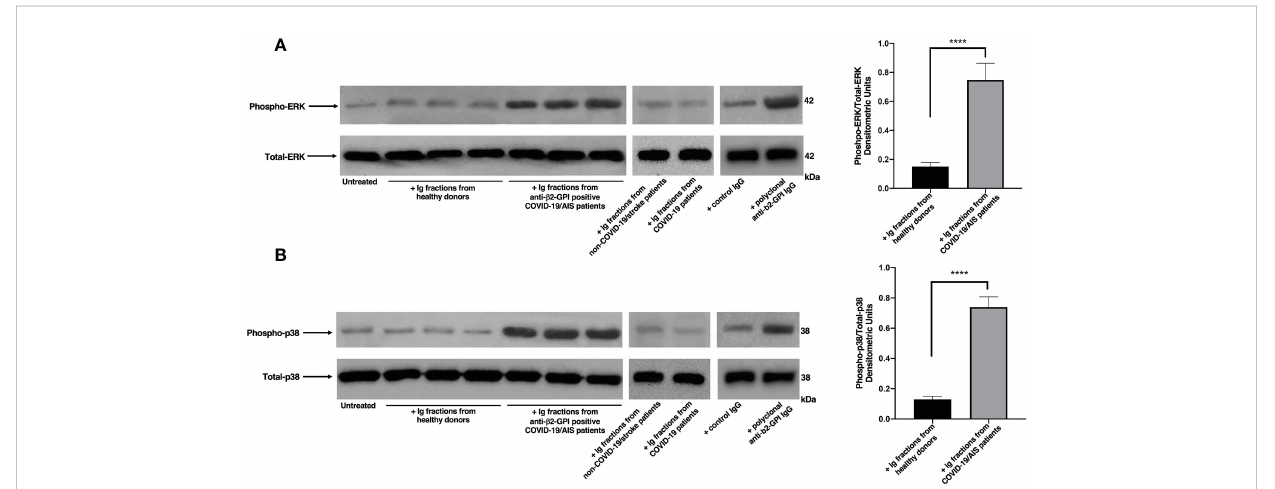
FIGURE 1 Ig fractions from patients with AIS during COVID-19 induce ERK and p38 phosphorylation. Human platelets from healthy donors were treated for 10 min with Ig fractions (200 m g/ml) from AIS/COVID-19 patients, non-COVID-19 stroke patients, COVID-19 patients without vascular thrombosis and from healthy donors or with polyclonal anti- b 2-GPI IgG (200 m g/ml). Protein extracts were separated by SDS-PAGE and analyzed by western blot to investigate phosphorylated ERK (A) and p38 MAPK (B) using anti-phospho-ERK1/2 and anti-phospho-p38 antibodies, respectively. Samples from three representative healthy donors, three anti- b 2-GPI IgG positive patients with AIS during COVID-19 (n. 3, 4, 5 of Table 2), one representative non-COVID-19 stroke patient and one representative COVID-19 patient are shown. Densitometric values of phospho-ERK and phospho-p38 levels, calculated in all healthy donors and patients, are represented and summarized by histograms. A statistically signi fi cant difference between expression of phospho-ERK and phospho-p38 in patients with AIS during COVID-19 vs healthy donors was found (****p < 0.0001).